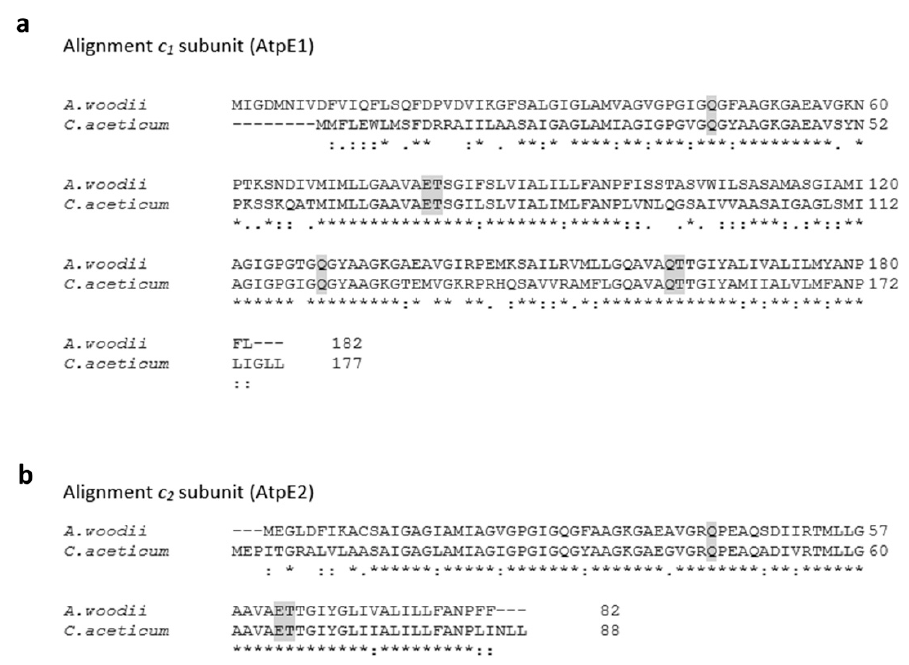
Figure 3. Model of the Na + F 1 F o ATP synthase of C. aceticum and comparison of the genetic organization of the atp operons of A. woodi and C. aceticum . The atp operon of A. woodii and C. aceticum coding for the F 1 F O -ATP synthase consists of 11 genes in A. woodii (Awo_c02140-Awo_c02240) and 10 genes in C. aceticum (CACET_c02130-CACET_c02220). The order of the genes is identical. C. aceticum misses atpE3 , coding for subunit c 3 , which is an exact copy of subunit c 2 in A. woodii . AtpI is not a subunit, but an assembly factor.